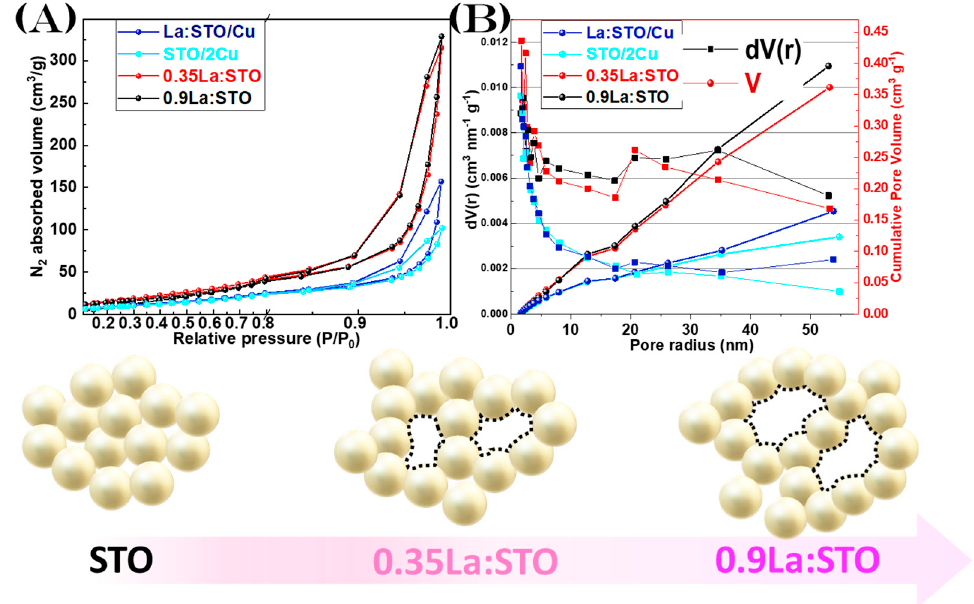
Figure 4. ( A ) Nitrogen adsorption isotherms for the SrTiO 3 -based nanoparticles. ( B ) The correspond- ing pore-size distribution plot using the BJH method and the Cumulative Pore Volume. Bottom : Schematic visualization of the La-doping effect on the nanomaterial aggregation.